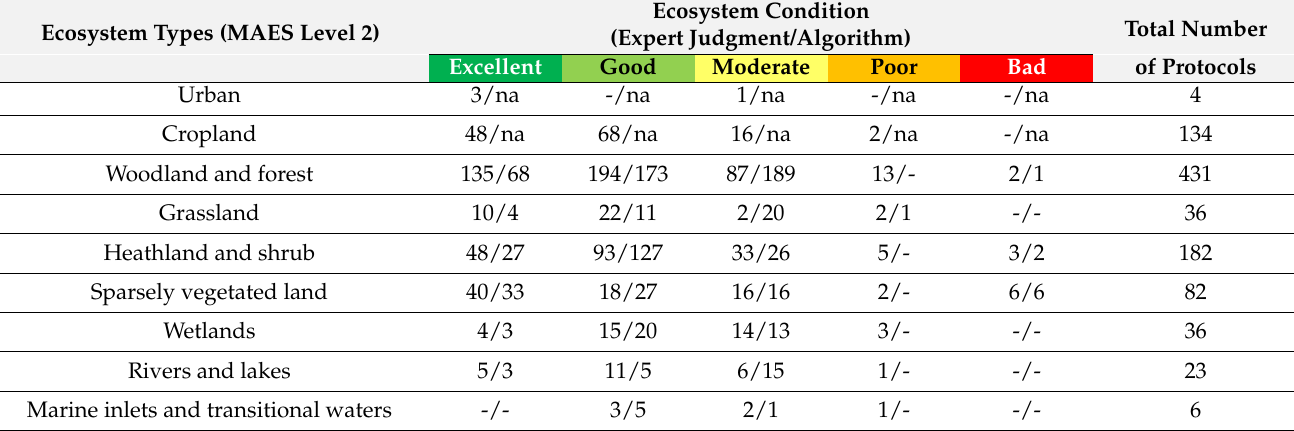
Table 4. Ecosystem condition results based on experts’ judgment and algorithm